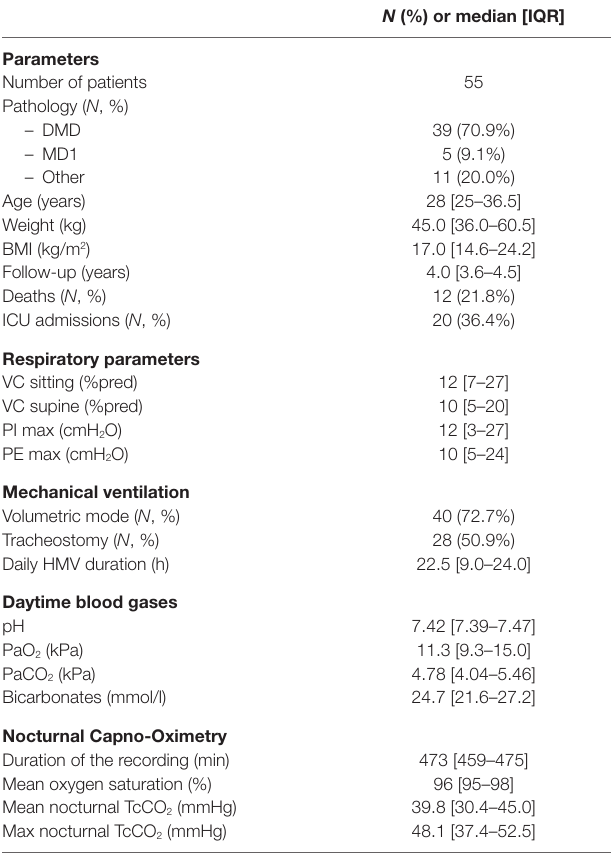
TaBle 1 | characteristics of the study population.